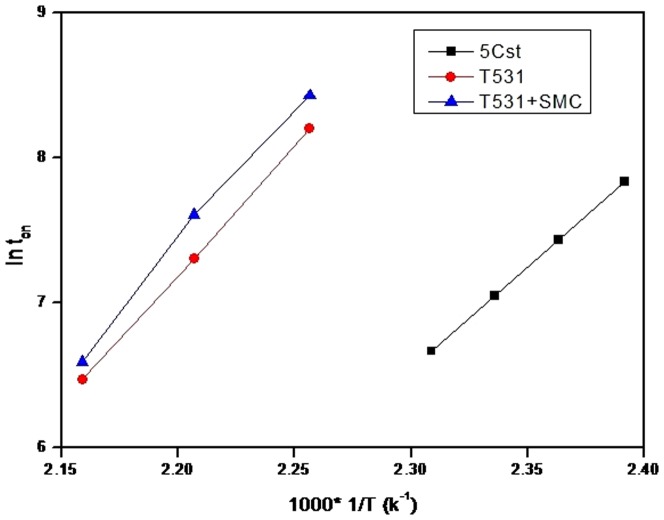
ln ton∼1/T curve at different temperatures.